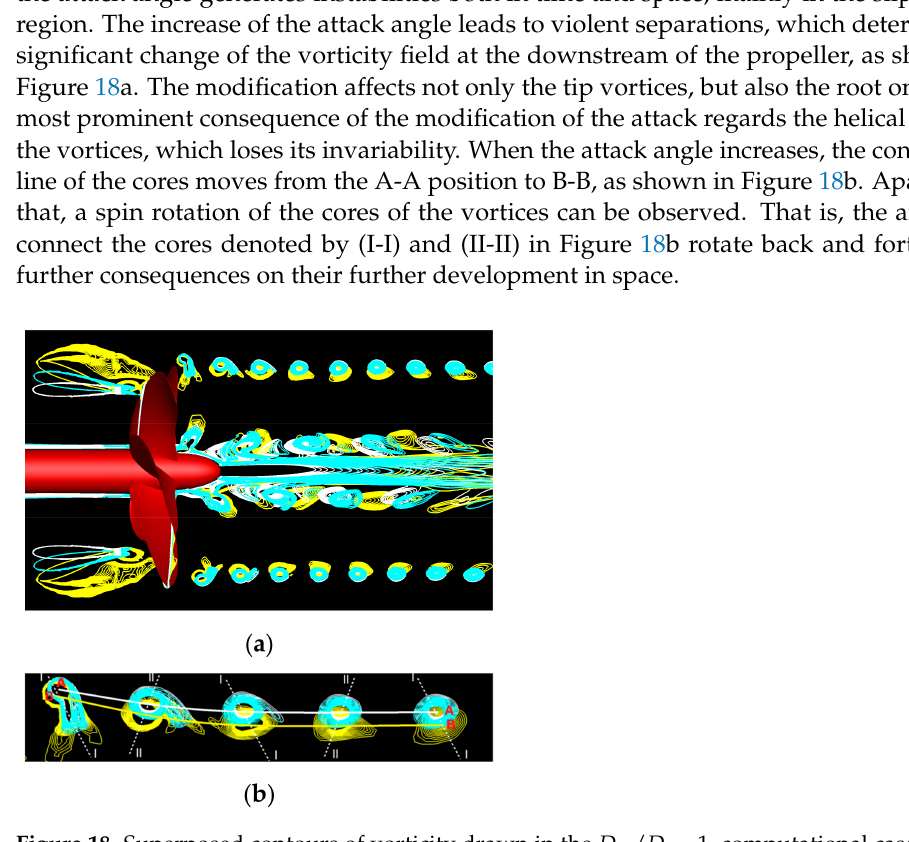
Figure 18. Superposed contours of vorticity drawn in the D N / D = 1 computational case. Attack angles: θ = 0 ◦ , θ = 10 ◦ and θ = 20 ◦ : ( a ) wake global view; ( b ) close-up